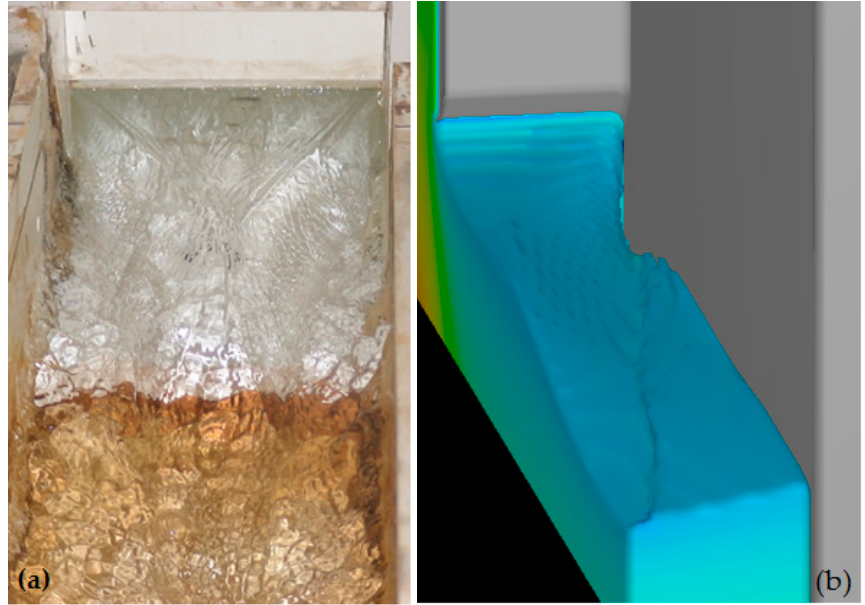
Figure 11. Symmetrical oblique waves downstream from the gate: ( a ) experimental and ( b ) numerical.